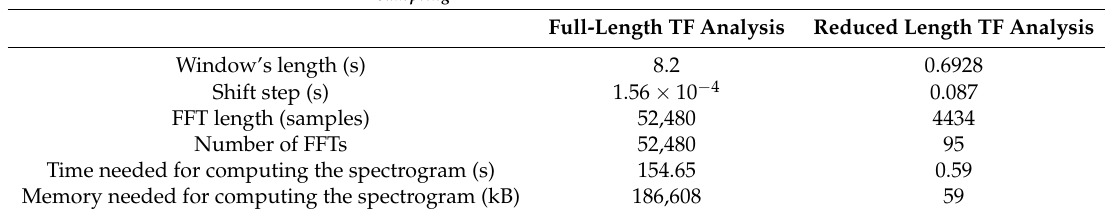
Table 2. Comparison of the parameters of the STFT of the current signal using the full-length and the proposed reduced length TF analysis, applied to the example presented in Section 4, where T s is the length of the current signal, F sampling is the sampling frequency and T W and B W are the parameters of the Slepian window obtained from Equation